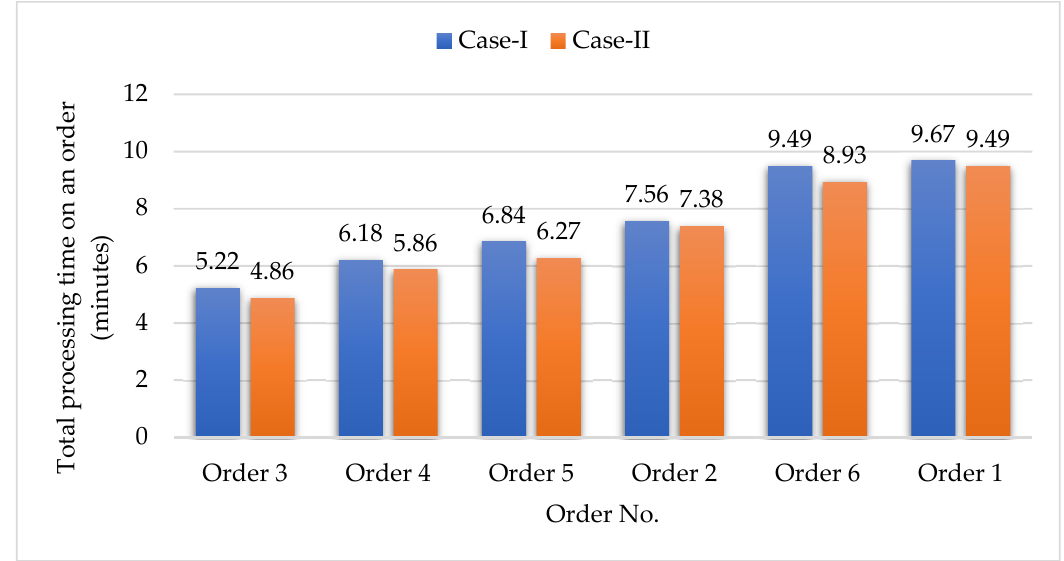
Figure 4. Comparison of the processing times for Case-I and Case-II using the EDD rule.